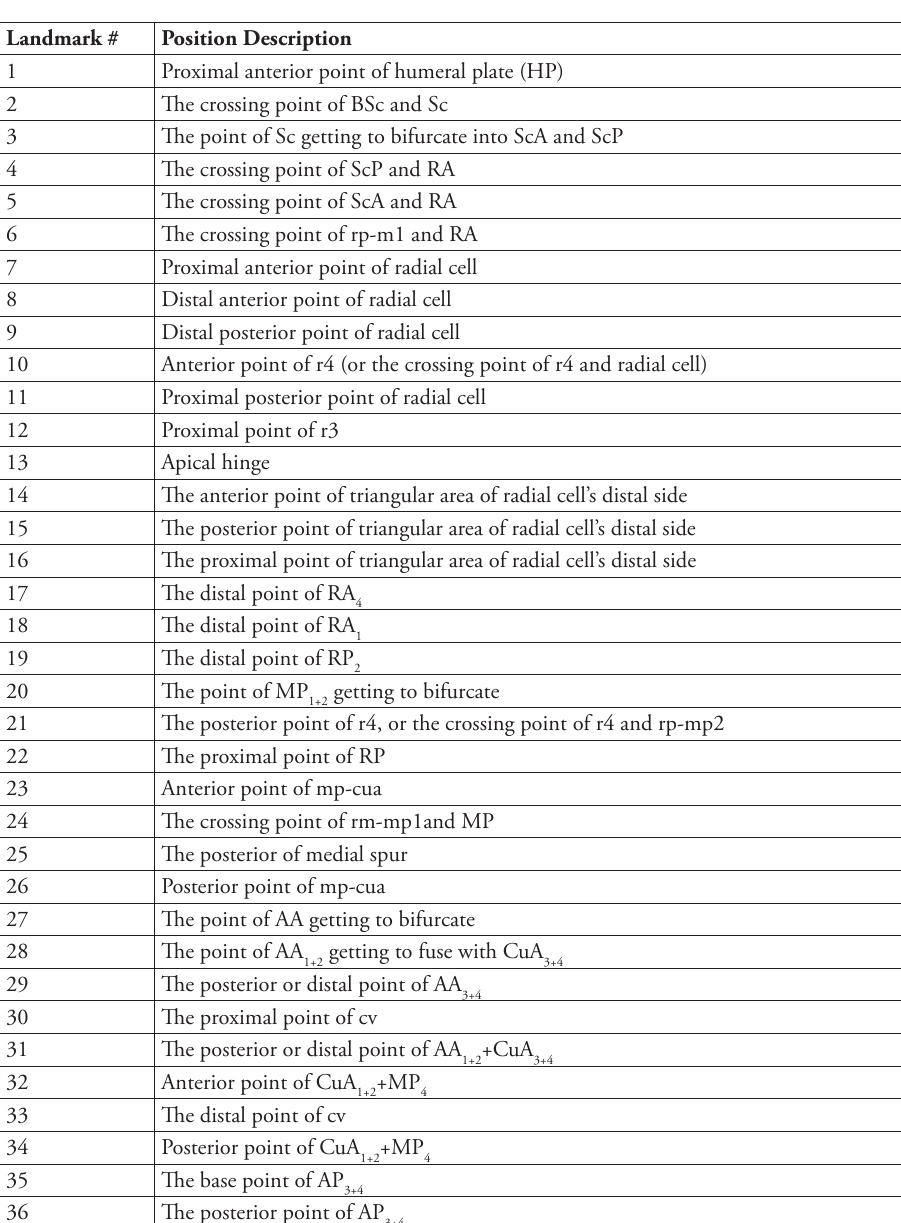
Table 1. Landmark position